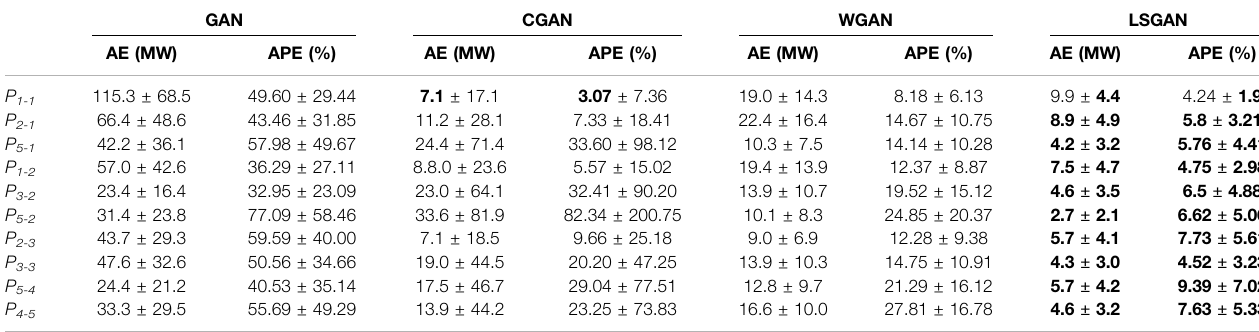
1 The bold values represent the minimum average error values and percentage error values of the active power obtained by different methods.